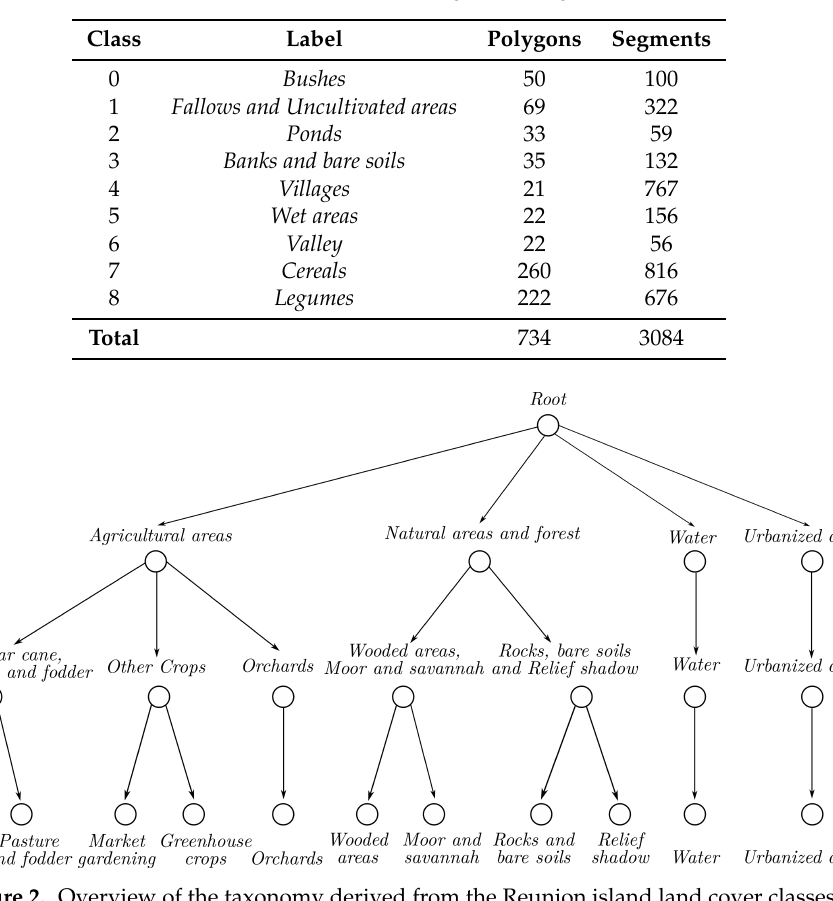
Table 2. Characteristics of the Senegalese site ground truth.